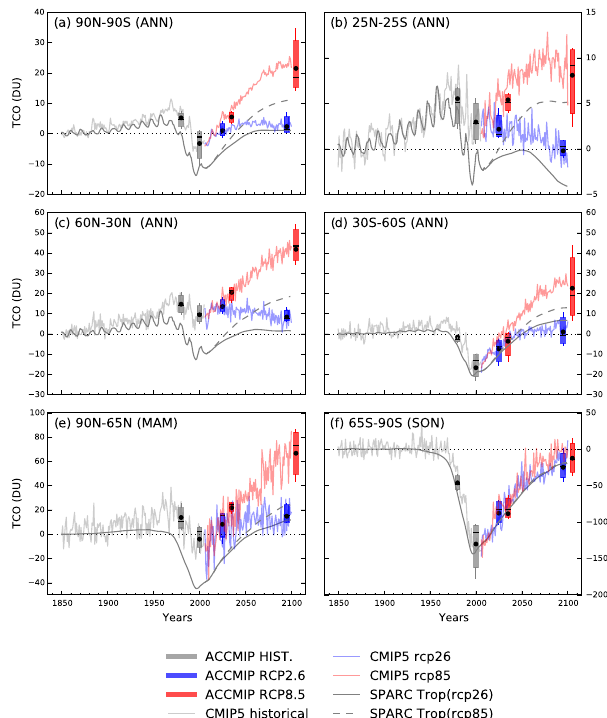
Figure 3. Total column ozone (DU) time series from 1850 to 2100, normalized to Hist 1850 time slice levels. The box, whiskers, and line indicate the interquartile range, 95% range and median respec- tively, for the ACCMIP CHEM models. In addition, the multi-model mean of the CMIP5 CHEM models and the IGAC/SPARC mean are